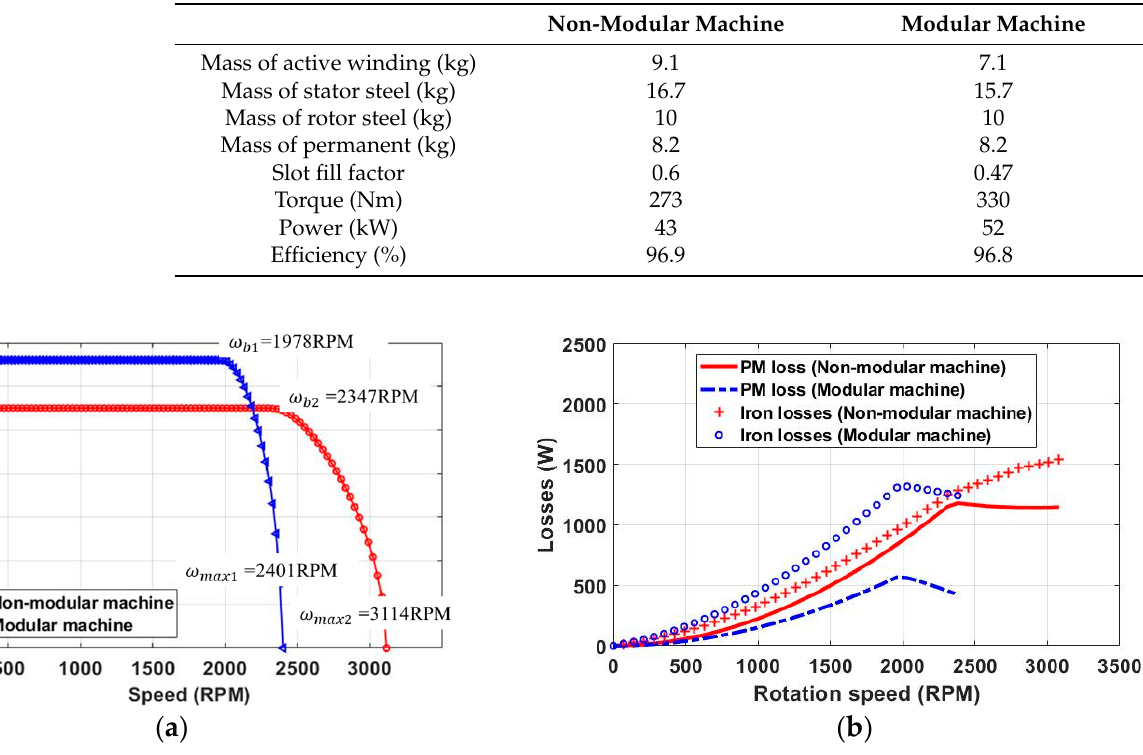
Table 2. Masses of active materials and key EM performance comparisons between the modular and non-modular SPM machine.